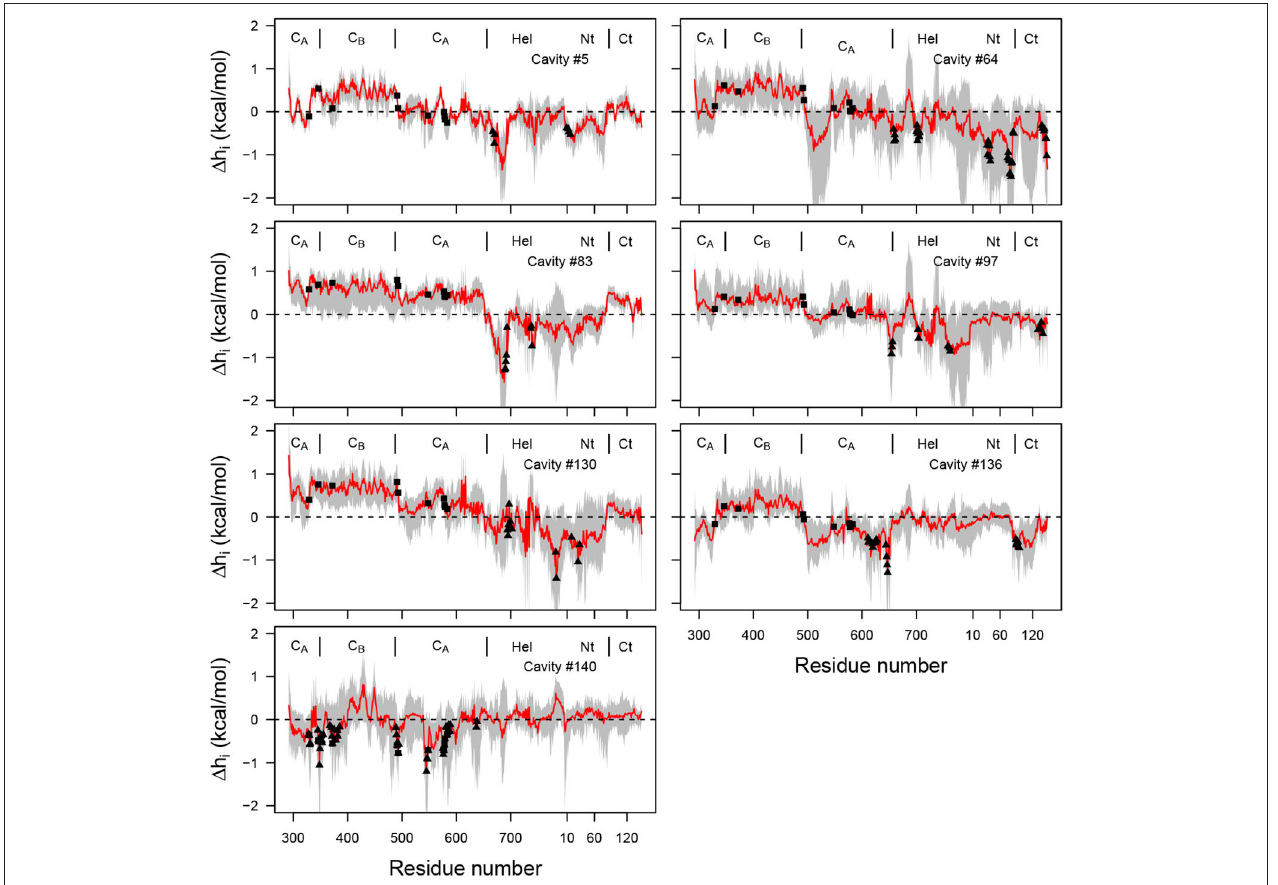
FIGURE 10 | Plot of free energy 1 h ( m ↑ ) i (kcal/mol) profile, where the probe residue m samples the residues defining each of the selected cavities ( Supplementary Table 3 ), and i samples all residues of the complex (x-axis). The average free energy profile is plotted in red with range of values drawn in gray. The residues defining the cavity ( Supplementary Table 3 ) are shown with filled triangles, and the residues 329, 346, 372, 577, 491, 493, 548, 578, 579, 583 of the catalytic site are shown with filled rectangles. The dashed line corresponds to the zero energy